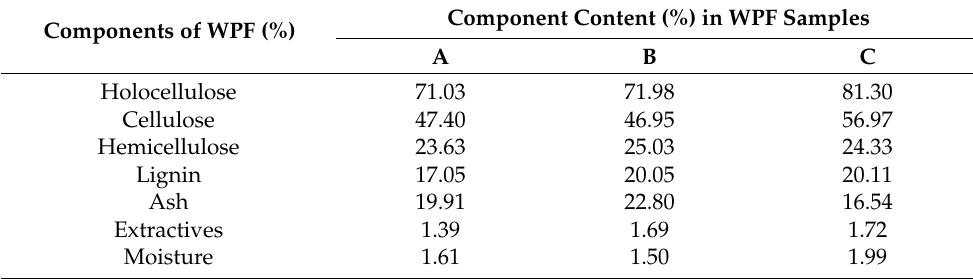
Table 2. Chemical composition of waste paper cellulose fiber (WPF)